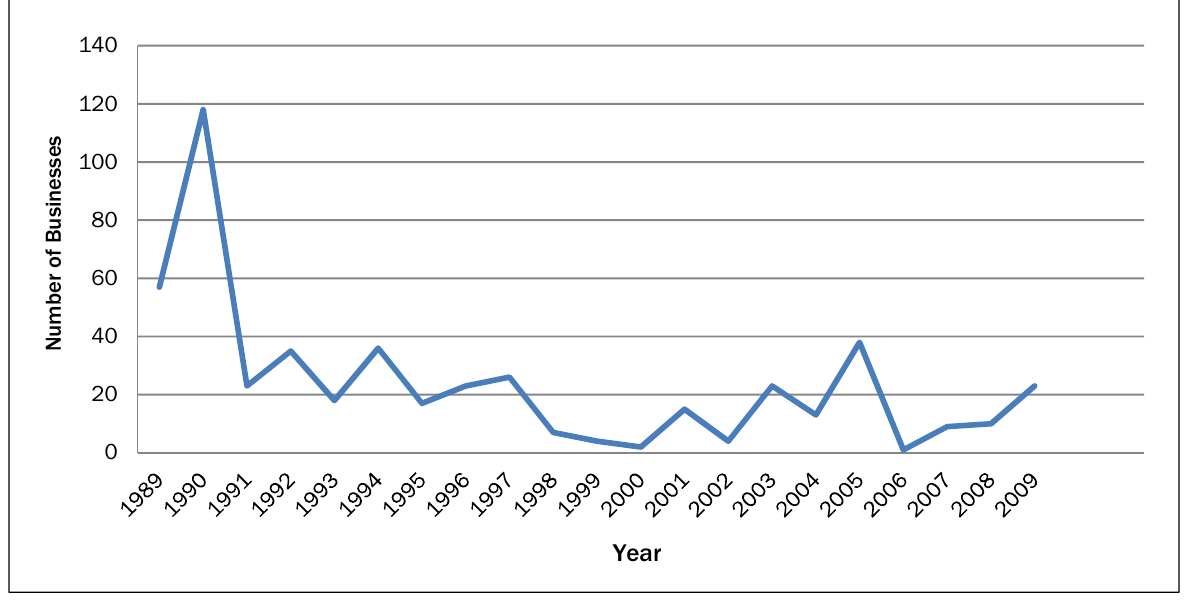
Source: Authors’ calculation from the National Agricultural Workers